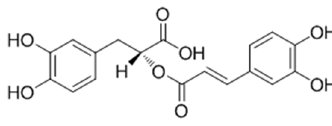
Figure 31. Structure of rosmarinic acid.